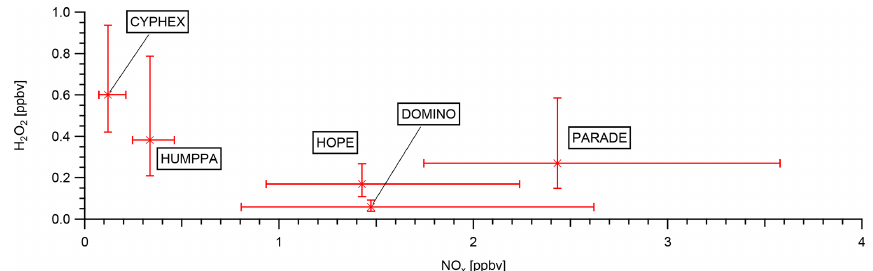
Figure 4. Relationship between H 2 O 2 and NO x for the five campaigns. Note that all data (day and night) have been used for the calculation of the median values and the 25%–75%